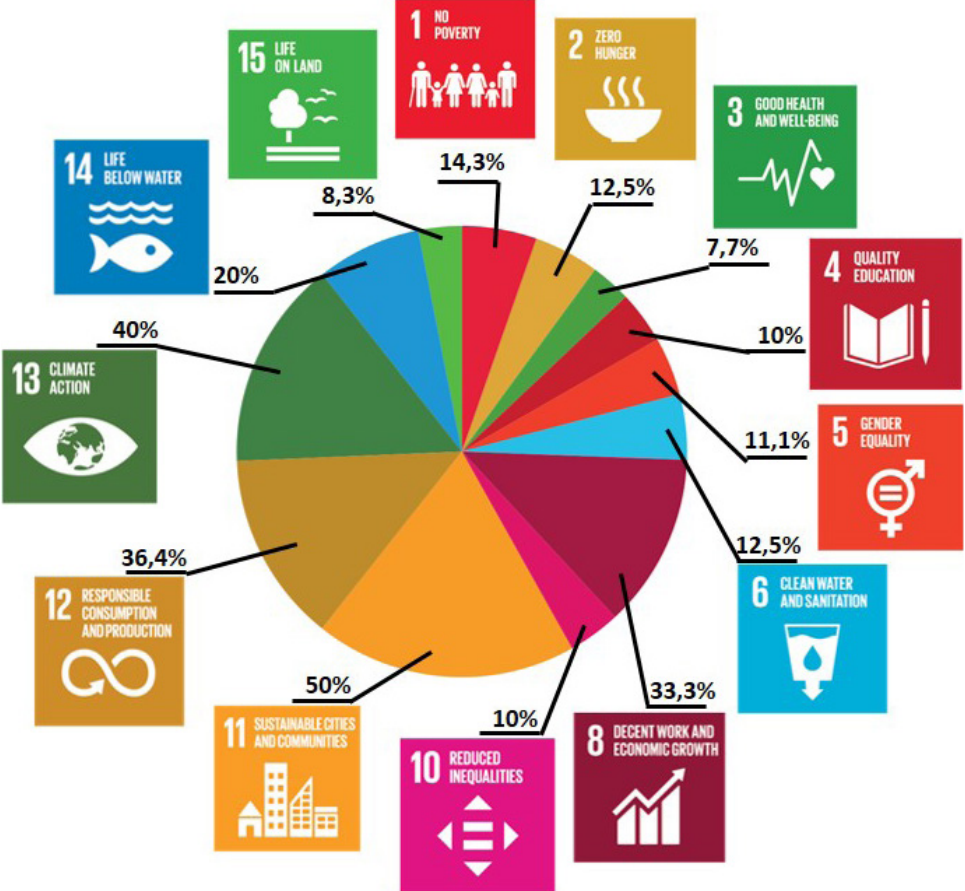
Figure 5. Percentage of targets associated with each SDG whose achievement can be facilitated by actions involving geosites on the north coast of São